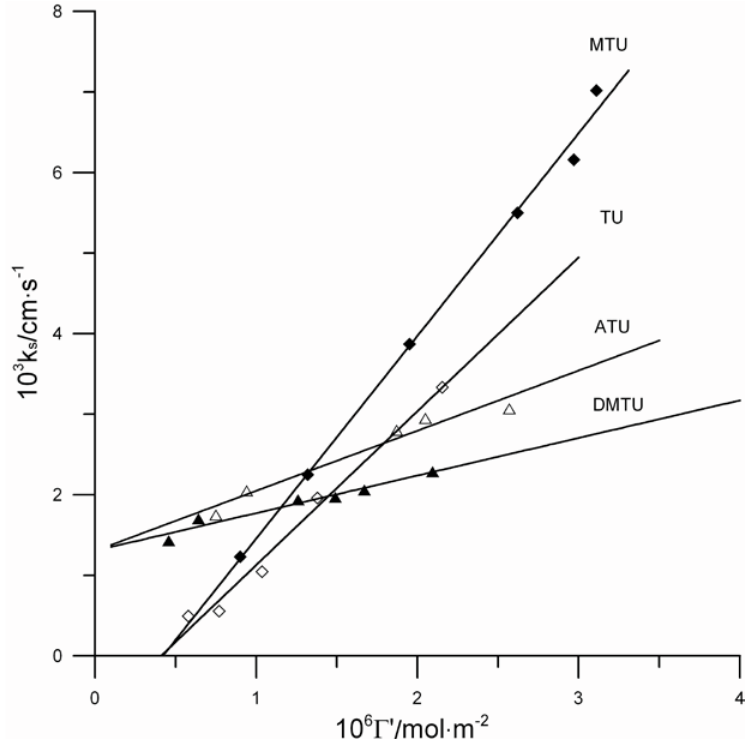
Figure 7. The dependence of standard rate constants k of: thiourea ( ◊ ) [ 45], N-methylthiourea ( ♦ ), N,N’-dimethylthiourea ( ▲ ) [ 46], N-allylthiourea ( D ) on adsorbate surface excess ( Г′